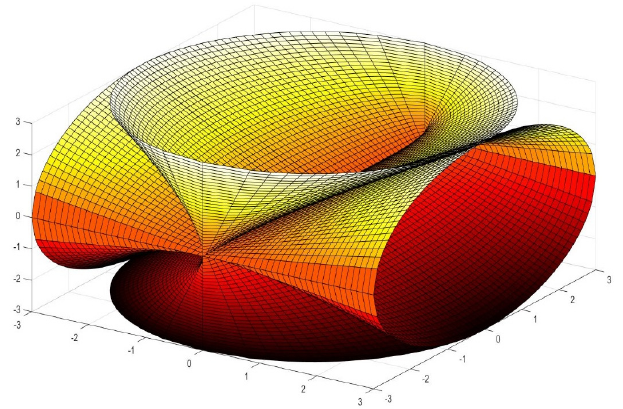
Figure 12. Distorted depiction of the complete Dyosphera .